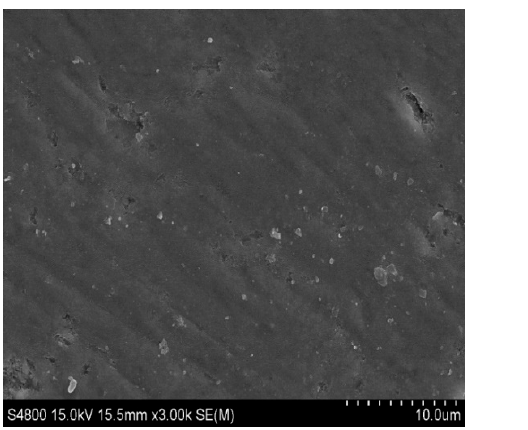
Figure 10. Micromorphology of 90# calcined bauxite surface after polishing ( × 2000).